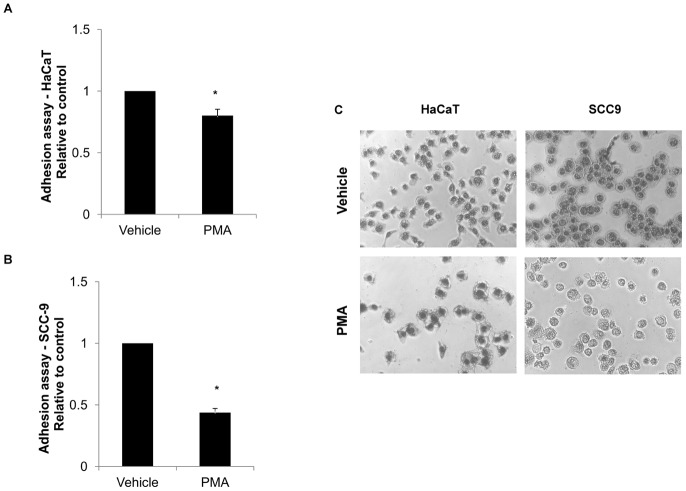
PMA promoted the loss of adhesion in Matrigel™ in HaCaT cells and SCC-9 cells.Adhesion assay showed that the cells stimulated by PMA decreased the ability to adhere to extracellular matrix proteins. HaCaT (A) and SCC-9 (B) cells had the ability to adhere in Matrigel™ diminished after 24 h of PMA treatment. Three independent experiments were performed with triplicates. Columns represent mean ± SD (n = 3) and * indicates p<0.01, normalized with the control (vehicle: DMSO). (C) Representative micrographs (magnification 40×) of adherent cells after PMA and vehicle (DMSO) treatments.